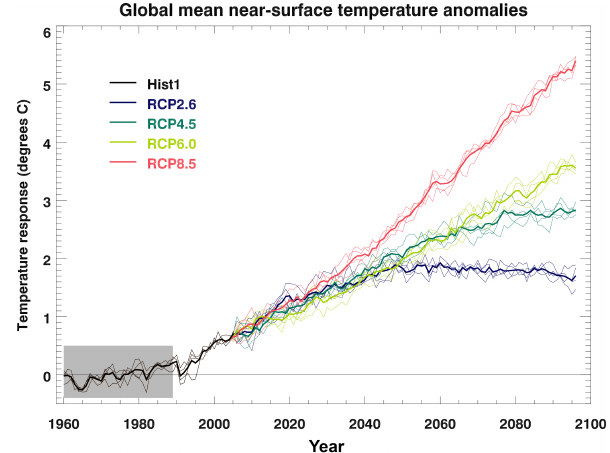
Figure 1. Global mean near-surface air temperature anomalies for HadGEM2-ES for the IPCC CMIP5 historical forcing scenario (black), followed by RCP8.5 (red), RCP6.0 (light green), RCP4.5 (dark green), and RCP2.6 (blue). The shaded region indicates the 1960–1989 reference period. Bold lines show the ensemble means, and thin lines show the individual ensemble members in each case. Figure 2. The region of the Arctic used in the analysis. For